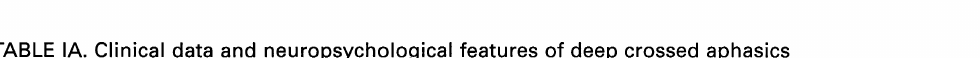
TABLE IA. Clinical data and neuropsychological features of deep crossed aphasics Case